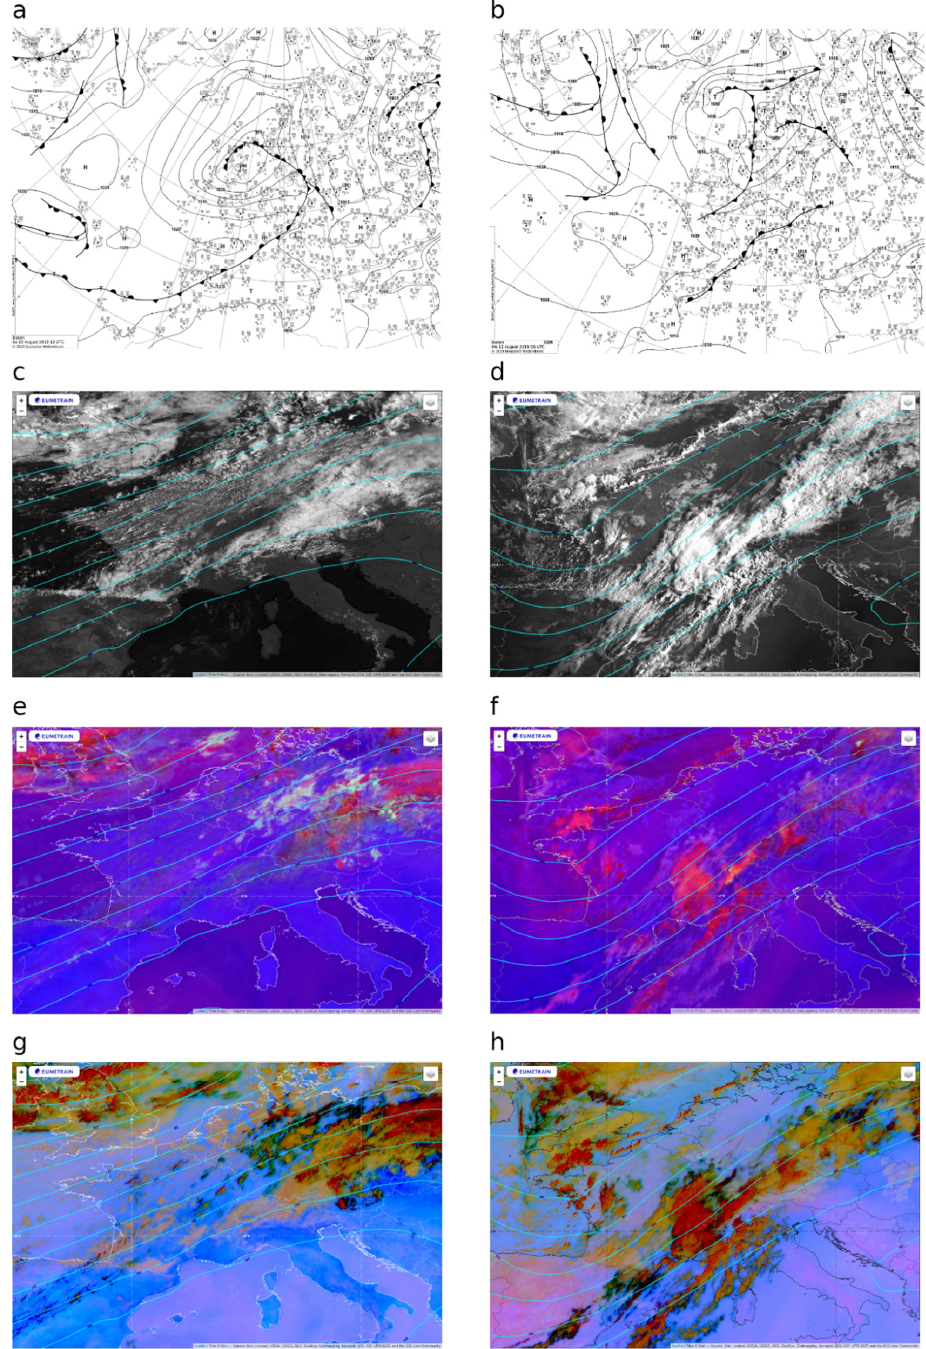
Figure 3. ( a , b ) Surface pressure chart analysis, with station data, fronts and isobars; ( c , d ) satellite HRV (High-Resolution Visible) image; ( e , f ) satellite RGB convection-enhanced product (red and orange indicate high convection); ( g , h ) satellite RGB Dust product (yellow: low clouds; green: middle clouds; black-dark red: high clouds; red: convective clouds). Blue lines on satellite images represent geopotential heights at 500 hPa in decametres. Left panels ( a , c , e , g ) refer to Saturday 10th August 2019 at 1200 UTC, while right panels ( b , d , f , h ) refer to Monday 12th August 2019 at 0600 UTC. Source DWD Archive for panels a and b, Eumetrain for satellite images.